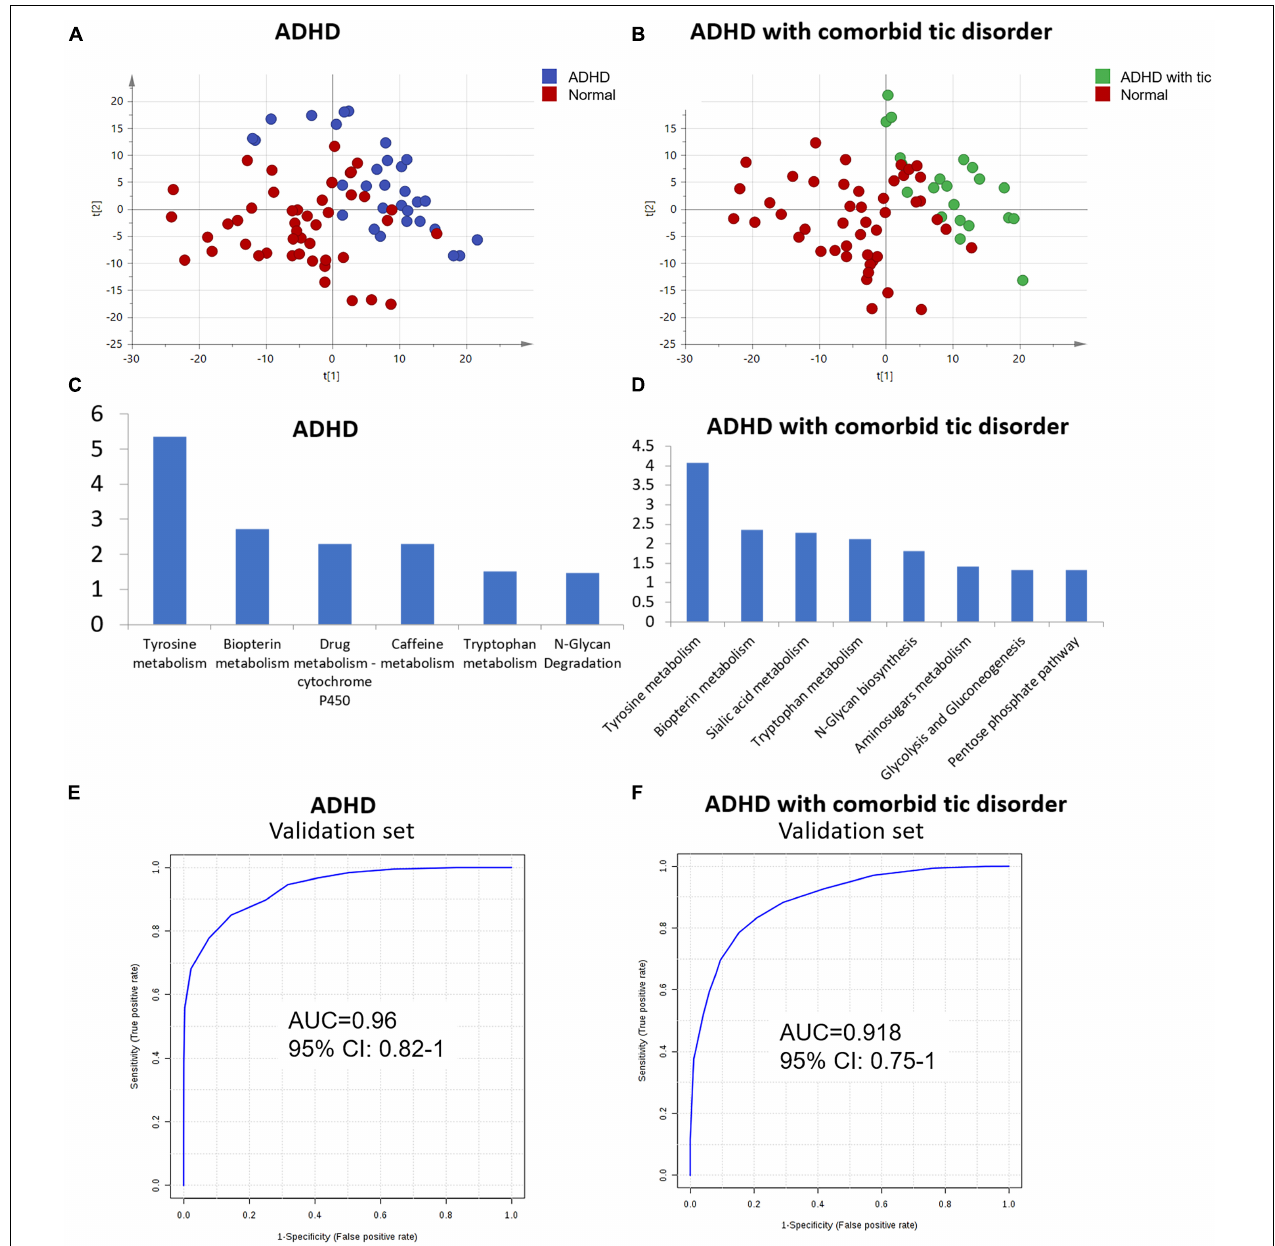
FIGURE 3 | Analysis of metabolome interindividual variations and related factors. (A) The score plot of the PCA model between ADHD without tic disorder and normal controls. (B) The score plot of PCA based on urine profiling of ADHD comorbid with tic disorder and normal controls. (C,D) Enriched pathway of metabolites for ADHD with/without tic disorder. (E,F) ROC plot of the validation set of ADHD patients with/without tic